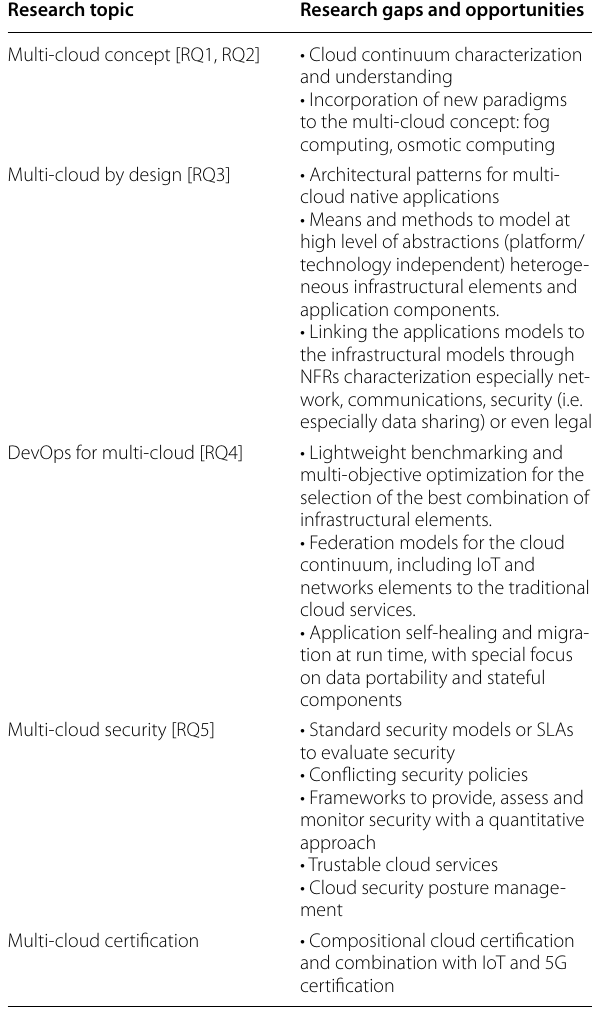
Table 10 Overview of research gaps and opportunities identified Research